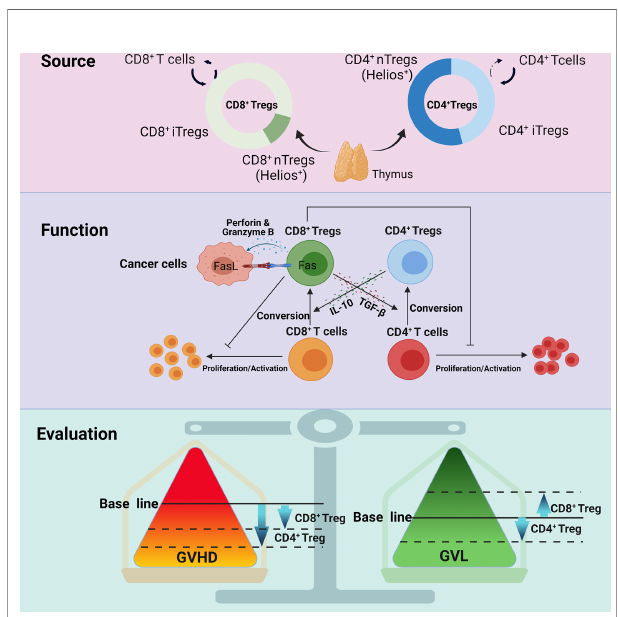
FIGURE 1 | The different manifestations between CD8 + Tregs and CD4 + Tregs with regard to source, function and evaluation. CD8 + Tregs mainly derive from CD8 + T cells and rarely from the thymus; CD4 + Tregs originate from both sources. CD8 + Tregs secrete cytokines, such as IL-10 and TGF- b , and exert an in fl uence on GVHD, but their GVL effect mainly depends on the Fas-Fasl interaction, perforin and granzyme B This may be the reason why CD8 + Tregs retain GVL but that CD4 + Tregs partially impair GVL. Studies also indicate that CD4 + Tregs are more powerful in regulating